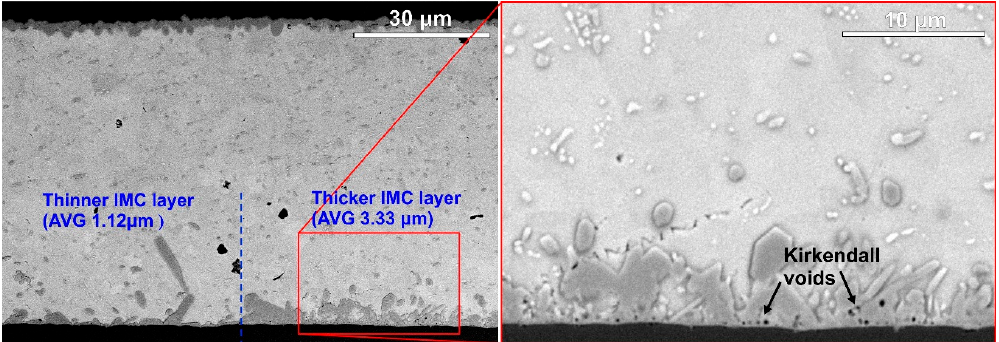
Figure 8. BSE-SEM micrographs of a SACX0307-nanoTiO 2 solder joint under the thermal pad.